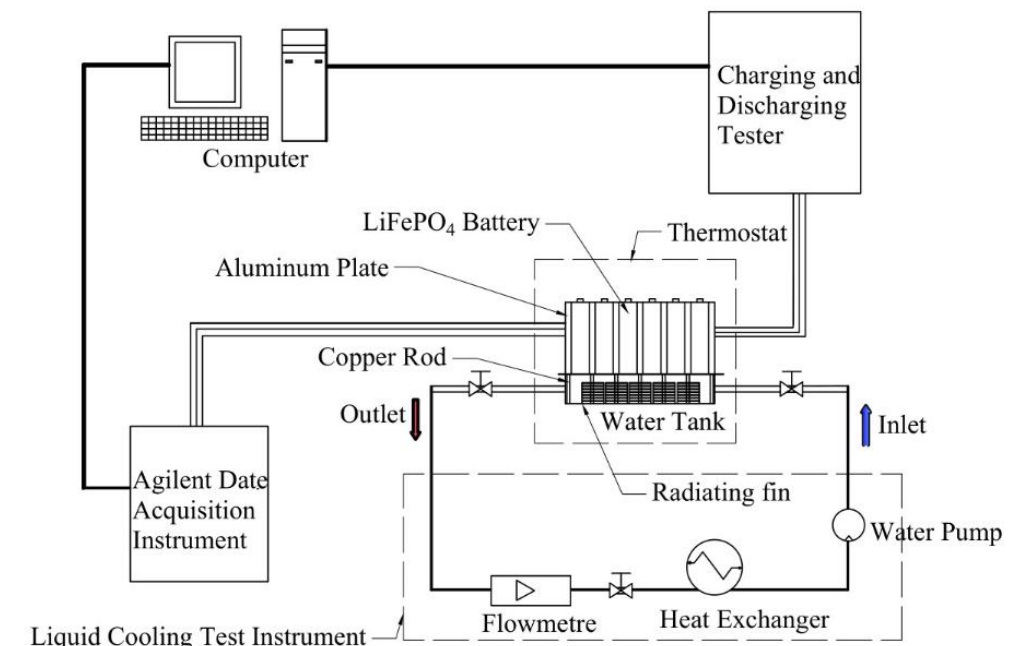
Figure 5. The working principle of CCCS.